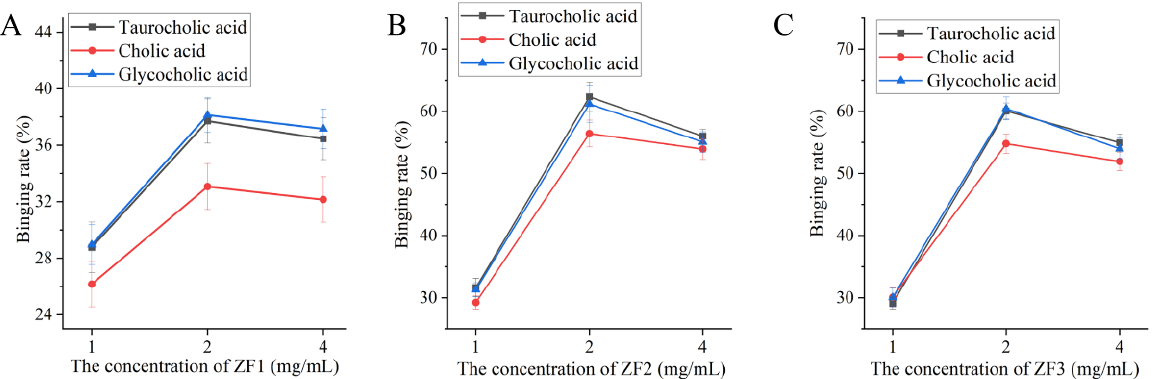
Figure 5. Bile acid binding rate of ZF1, ZF2,, and ZF3. ( A ) The binding rates of three different concentrations (1, 2, 4 μ g/mL) of ZF1 to taurocholic acid, cholic acid and glycocholic acid; ( B ) the binding rates of three different concentrations (1, 2, and 4 μ g/mL) of ZF2 to taurocholic acid, cholic acid, and glycocholic acid; ( C ) the binding rates of three different concentrations (1, 2, 4 μ g/mL) of ZF3 to taurocholic acid, cholic acid, and glycocholic acid.